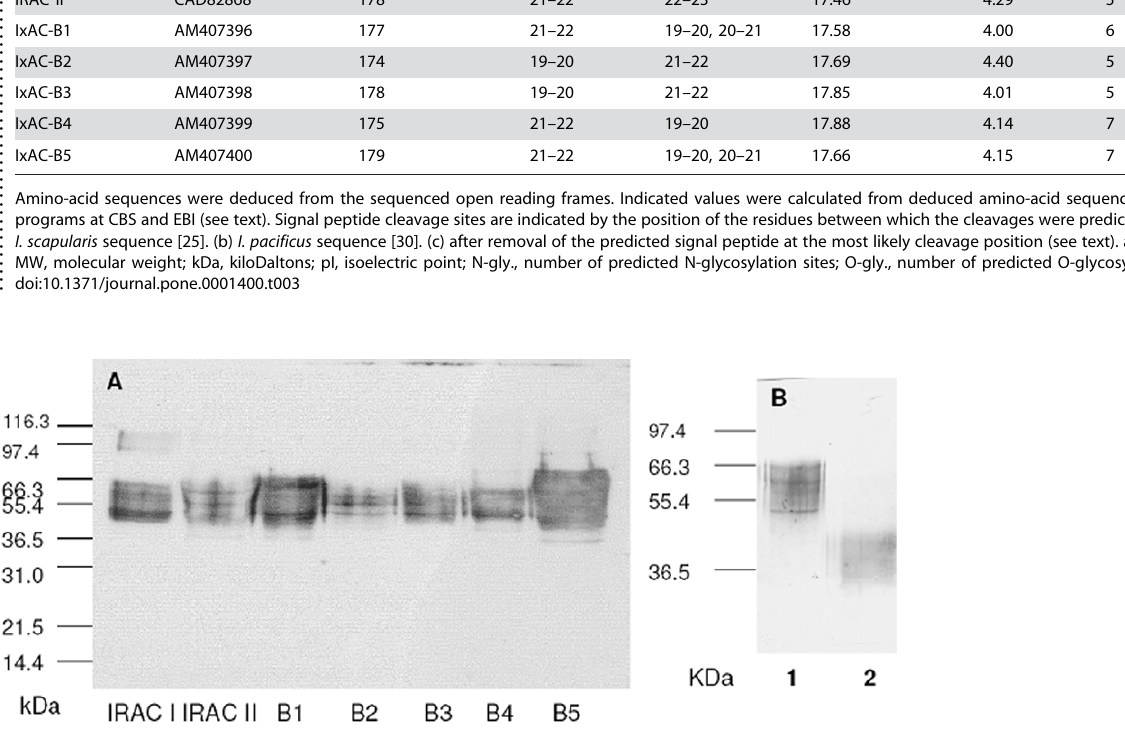
Figure 3. Western blot analysis of recombinant IxAC-V5His proteins from I.ricinus. Standardised amounts of recombinant IxAC-V5His proteins from supernatants of transfected 293T cells were analysed by SDS/PAGE and detected by western blotting using an anti-V5 monoclonal antibody. A) Parallel analysis of IxACs, B) N-deglycosylation of IxAC-B1-V5His.1, untreated, 2, incubated with PNGase (New England Biolabs).